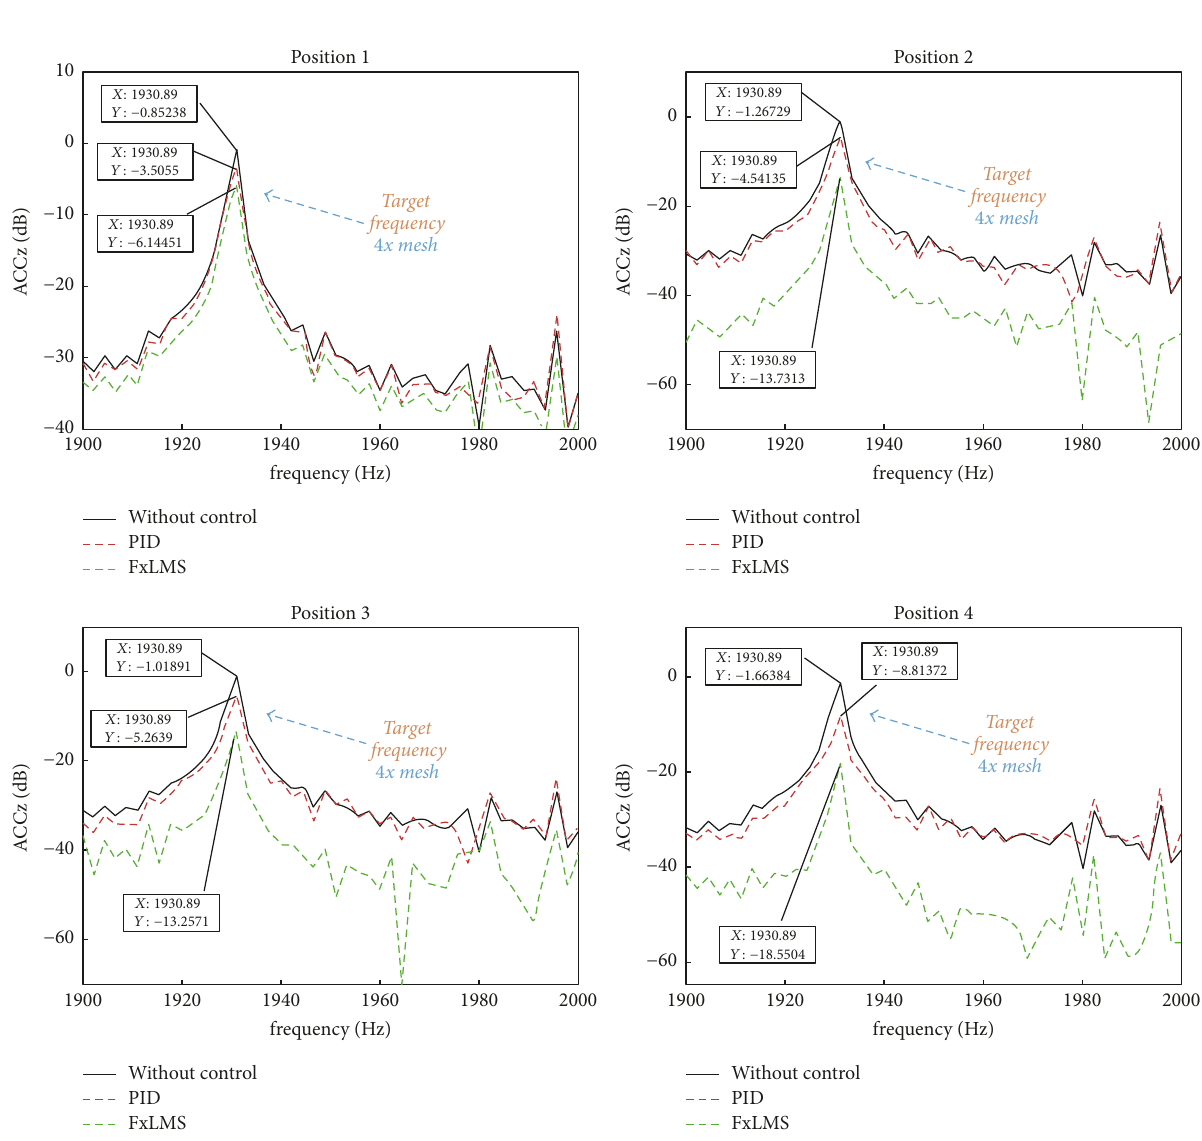
Figure 9: The cosimulation results of the four different positions for fixing the